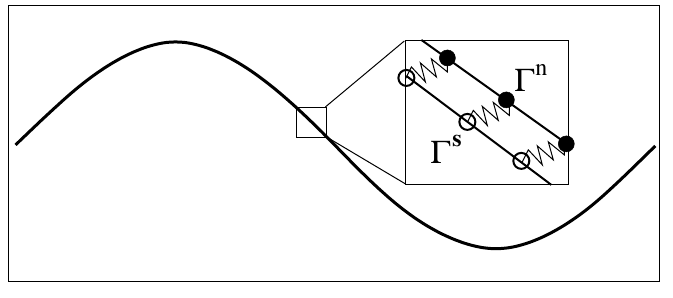
Figure 1. Dual IB representation of a swimmer. • − X n ( q,t ) , ◦ − X s ( q,t )